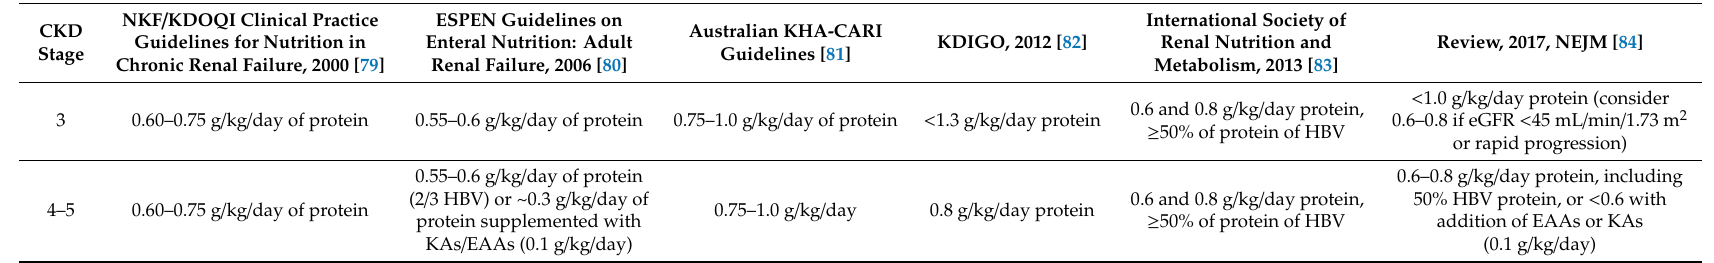
Table 4. VLDP / LDP and KA in non-dialyzed patients with chronic kidney